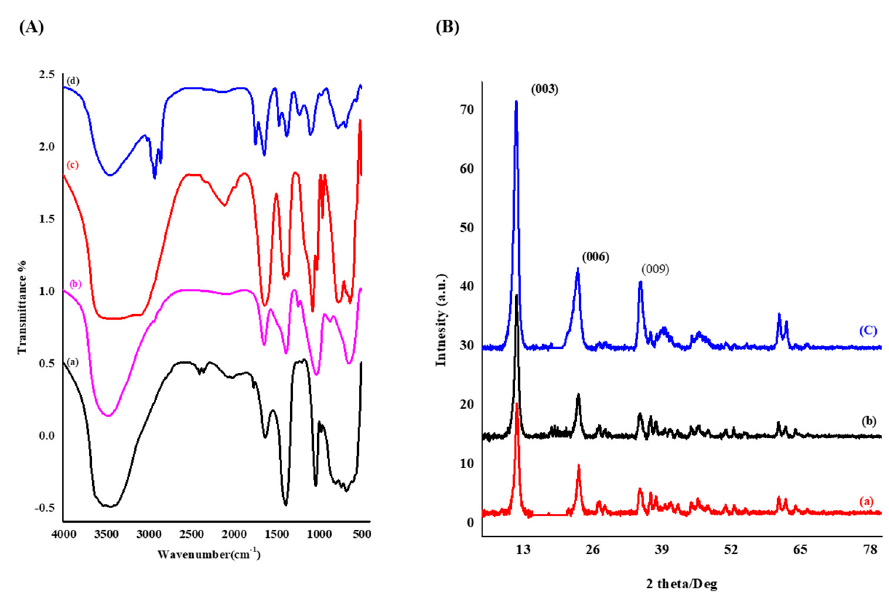
Figure 2. (A) FT-IR spectra of (a) CuAl-LDH, (b) DOX, (c) CuAl-LDH@DOX, and (d)